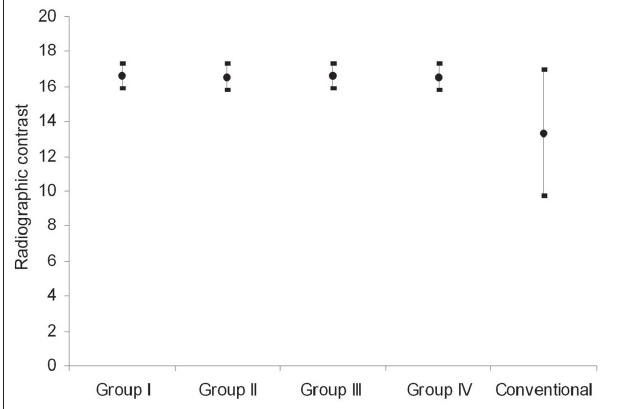
Fig. 3 – Comparison of mean values of radiographic contrast (± standard deviation) among all image